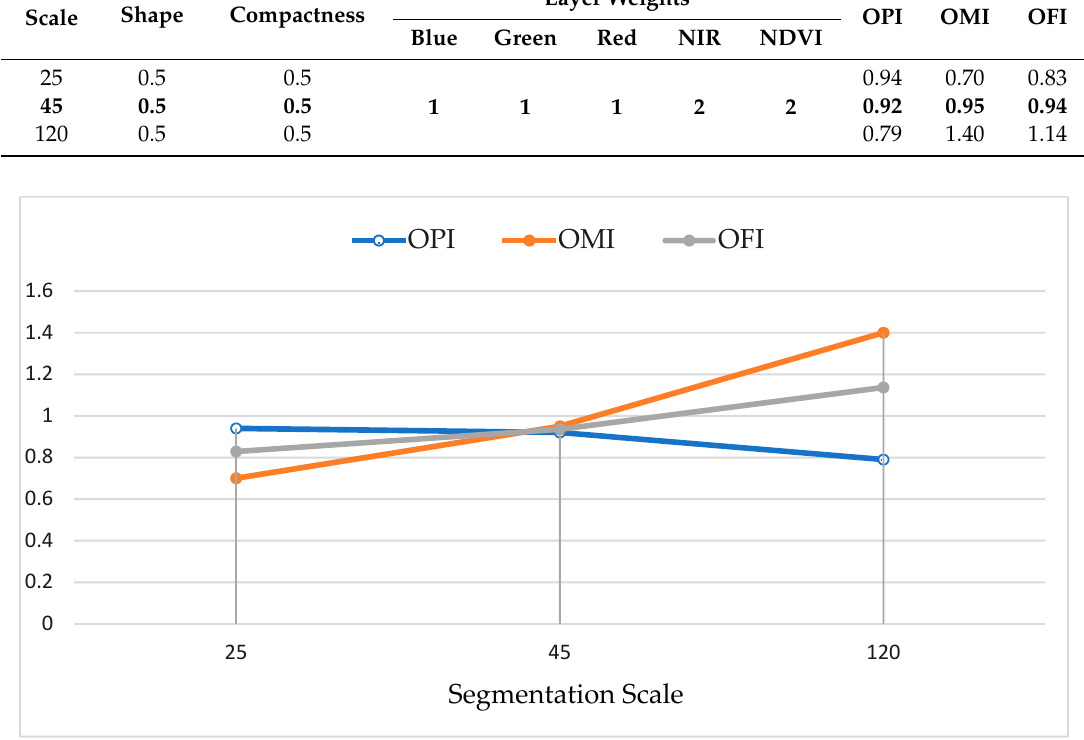
Figure 8. The variation of OPI, OMI, and OFI indices at different segmentation scales. At scale 45, all lines cross each other, showing the best scale value for image segmentation. Table 1. Segmentation parameters (optimal scale parameters are in bold) and the results of object evaluation indexes.